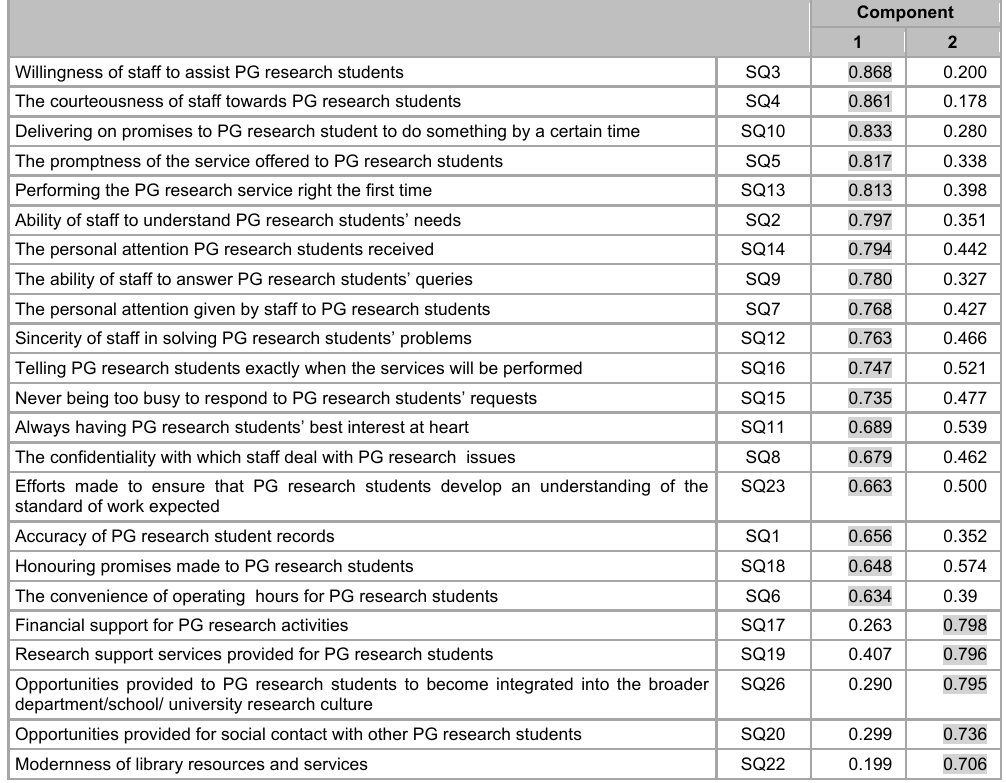
Factor loadings for the PGSQUAL research instrument